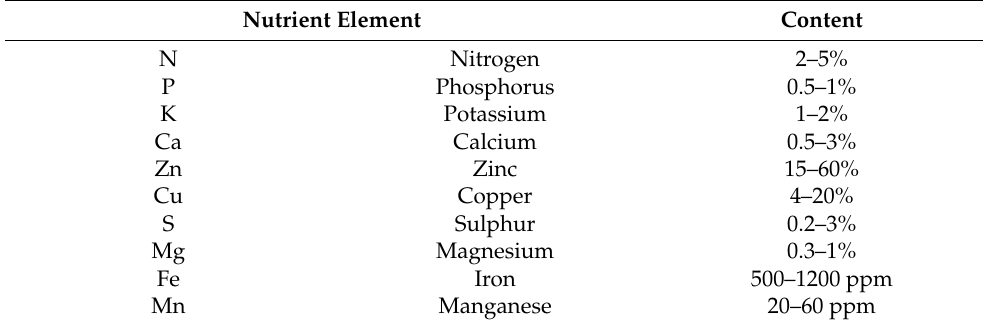
Table 5. Main nutrient element content as percentage ( % ) or as part per million ( ppm ) in neem cake. Nutrient Element Content